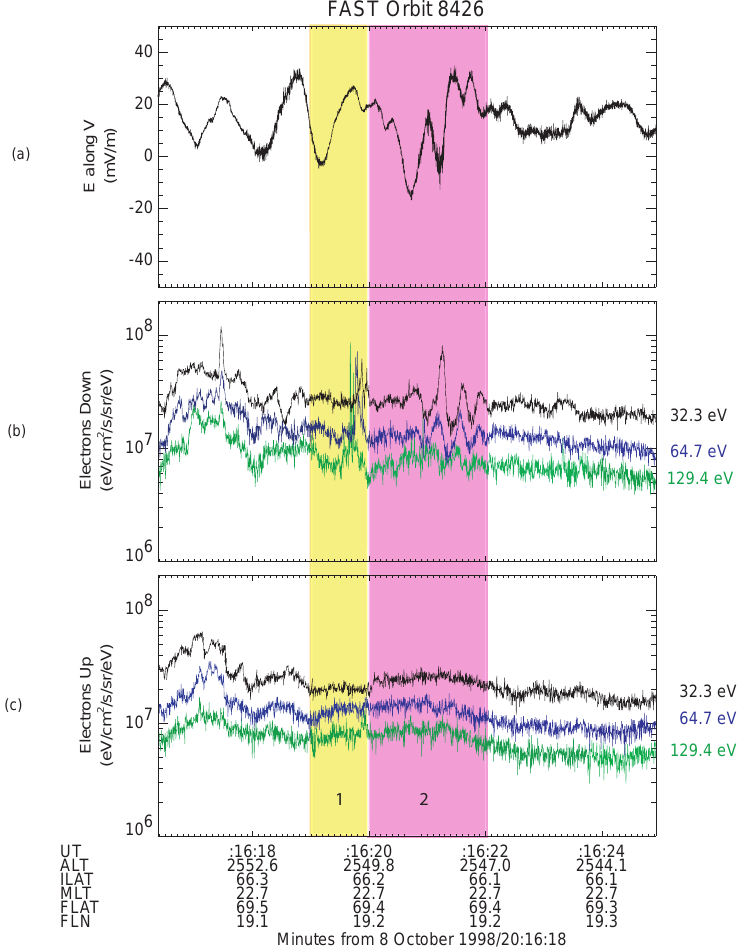
Fig. 3. FAST satellite data from 8 Oc- tober 1998. Panel (a) shows an elec- tric field component perpendicular to the magnetic field. Panels (b) and (c) show electron flux measured by the 32.3, 64.7 and 129.4eV channels of the SESA instrument directed downward and upward, respectively, with units of fluxes multiplied by the centre energy of the corresponding energy channel (after Robinson et al.,